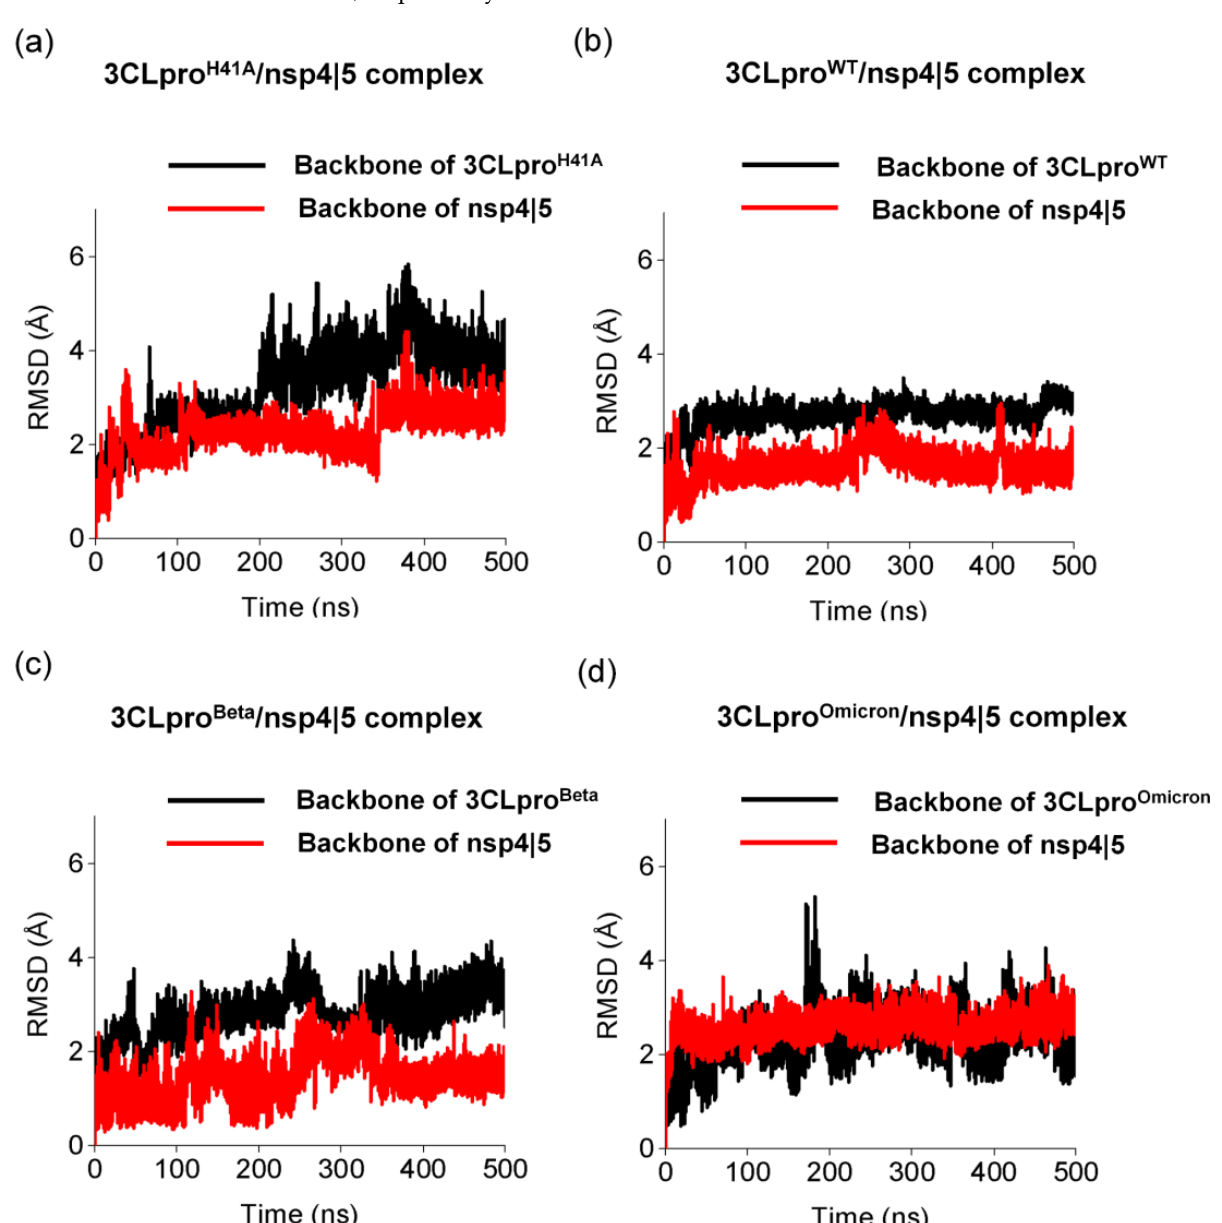
Figure 1. Structural changes of different 3CLpro variants while interacting with nsp 4|5 substrate. Backbone root-mean-square deviation (RMSD) of ( a ) 3CLpro H41A , ( b ) 3CLpro WT , ( c ) 3CLpro Beta , and ( d ) 3CLpro Omicron calculated using molecular dynamics simulations for 500